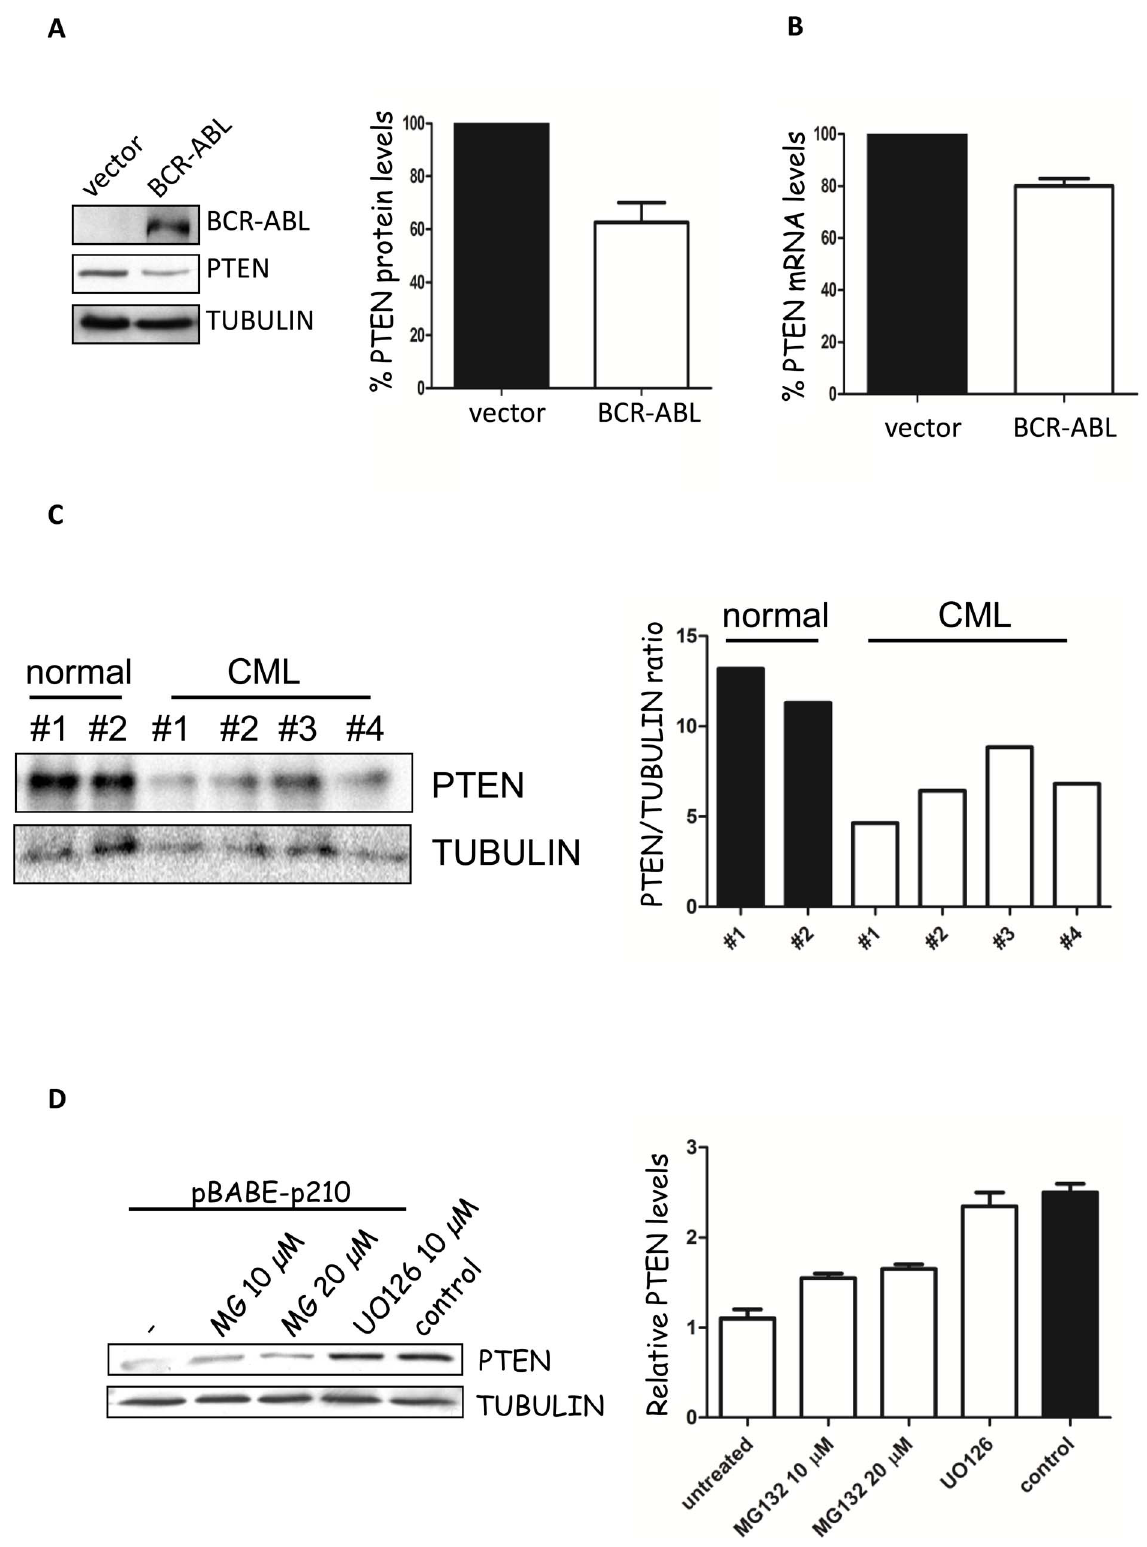
Figure 1. BCR-ABL downregulates PTEN expression. A) Left panel: evaluation of PTEN levels of expression in BCR-ABL-pcDNA3.1 transfected NIH3T3. Right panel: quantification of PTEN levels. B) PTEN mRNA levels in BCR-ABL transfected NIH3T3 cells. C) Left panel: PTEN levels by western immunoblot in primary CD34 positive cells obtained from the bone marrow of normal individuals and Chronic Myeloid Leukemia patients. Right panel: quantification of PTEN levels. D) Stably expressing pBabe-BCR-ABL infected NIH3T3 cells were treated with MG132 and UO126 for 8 hours. Control: parental NIH3T3 expressing pBABE-empty vector. doi:10.1371/journal.pone.0110682.g001 PLOS ONE | www.plosone.org